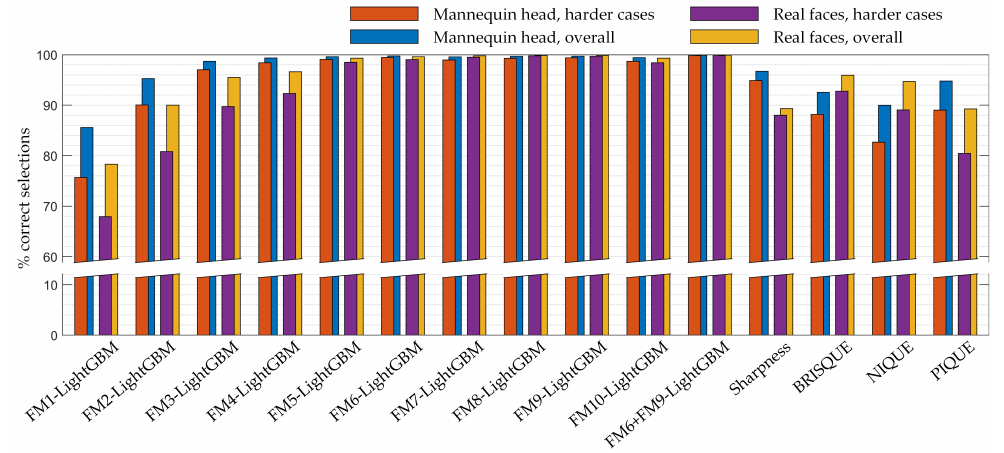
Figure 5. Graphical summary of all the experimental results of methods comparison. The results are the percentage of correct selections of a less motion-blurred image from a pair of images. Images of a mannequin head and of real faces were used. The chart gives the average performance of the methods tested using all image pairs (overall) and harder image pairs. Harder image pairs are image pairs that are the most similar according to the motion blur